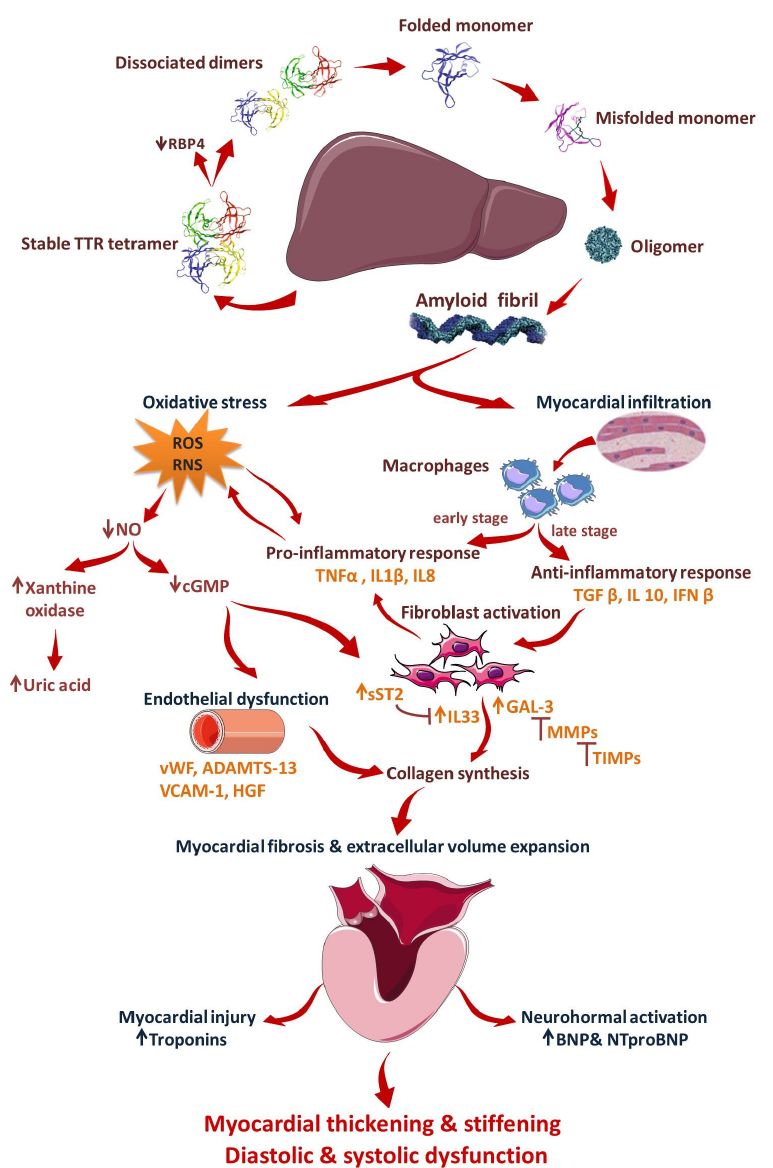
Figure 7. Mechanisms of cardiac impairment in ATTR amyloidosis. Mutations in TTR, a tetrameric protein, lead to its dissociation into dimers, subsequently into monomers that rapidly misfold and aggregate into oligomers, and eventually into amyloid fibrils. Amyloid fibrils infiltrate the myocardial walls, triggering the inflammatory response and fibroblast activation. Amyloid deposits increase oxidative stress, which exacerbates inflammation and induces endothelial dysfunction. These responses lead to myocardial fibrosis and extracellular volume expansion, with myocardial thickening and stiffening and diastolic and systolic dysfunction. TTR: transthyretin; RBP4: retinol binding protein 4; IL: interleukin; TNF α : tumor necrosis factor α ; TGF β :transforming growth factor β ; IFN β : interferon β ; RO: reactive oxygen species; RNS: reactive nitrogen species; NO: nitric oxide; cGMP: cyclic guanosine monophosphate; sST2: soluble suppression of tumorigenesis 2; Gal-3: galectin-3; MMPs: matrix metallopeptidases; TIMPs: tissue inhibitors of metalloproteinases; vWF: von Willebrand factor; ADAMTS-13: a disintegrin-like and metalloprotease with thrombospondin type 1 repeats-13; VCAM-1: vascular cell adhesion molecule-1; HGF: hepatocyte growth factor ( images for tetrameric proteins and their dissociation products were modified from Coelho T. et al. Neurol Ther 5 , 1–25 (2016) with permission under CC BY 4.0)